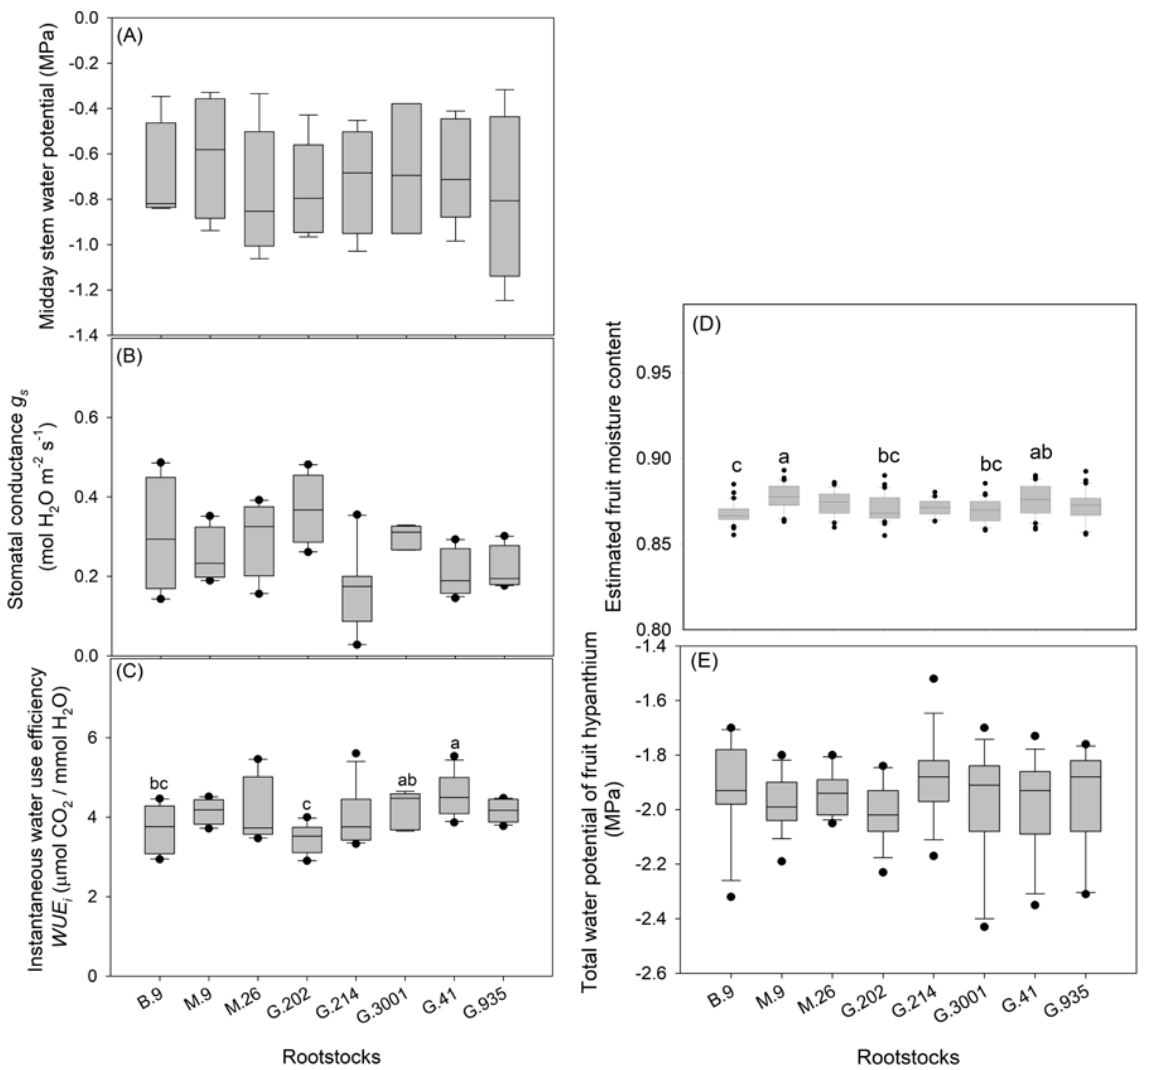
Figure 5. Tree–water relations of Honeycrisp apple on eight rootstocks. ( A ) Midday stem water potential Ψ stem , ( B ) stomatal conductance g s , and ( C ) instantaneous water-use efficiency WUE i were measured 46–52 h after irrigation in August 2019; and ( D ) fruit moisture content (weight ratio) and ( E ) fruit total water potential Ψ fruit were assessed at harvest in mid- September 2019. Different letters in each sub-panel stand for significant difference amongst rootstocks ( p ≤ 0.05, ANOVA, Tukey–Kramer Pairwise Comparisons; ( A – C ): n = 6; ( D ): n = 30; ( E ): n = 15).